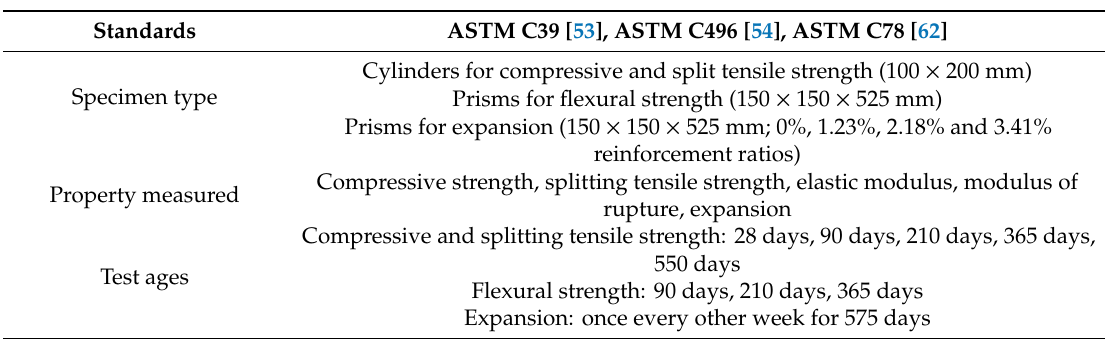
Table 5. Test plan for the concrete mixtures with Type II cement and El Paso sand: NaOH-00 and